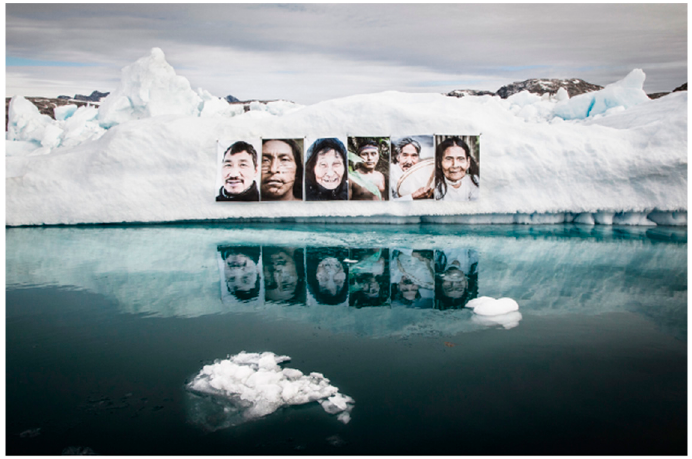
Figure 6. Barbara Dombrowski, Tropic Ice. Source: https://www.barbaradombrowski.com/installationamazonia-greenland (accessed on 30 August 2022). Courtesy Barbara Dombrowski.